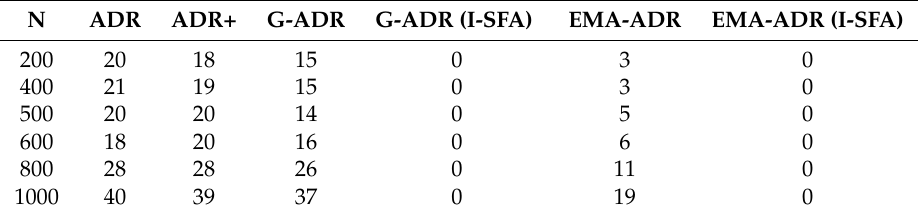
Table 4. Convergence period in hours for static EDs (with starting SF = 12, uplink period = 24 packets/day, and total simulation time = 4 days).